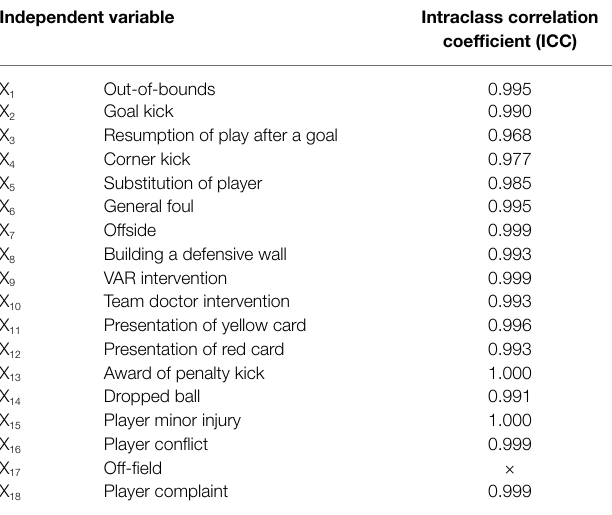
TABLE 2 | Interclass correlation coefficient and correlation values for variables. Independent